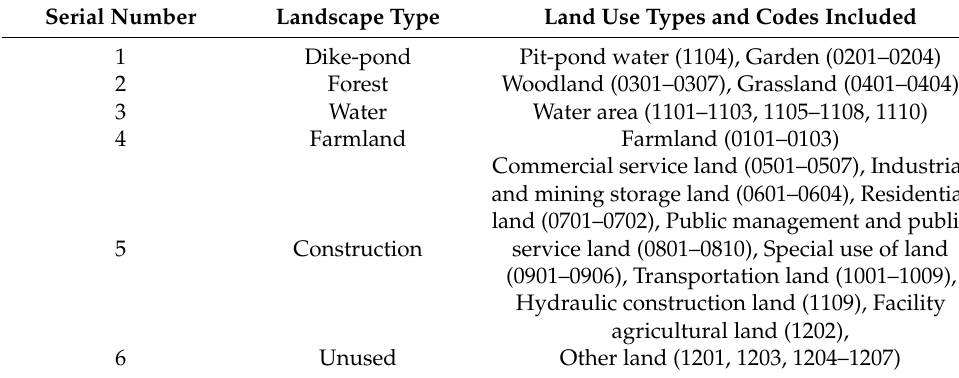
Table 2. Classification and basis of landscape types in the study